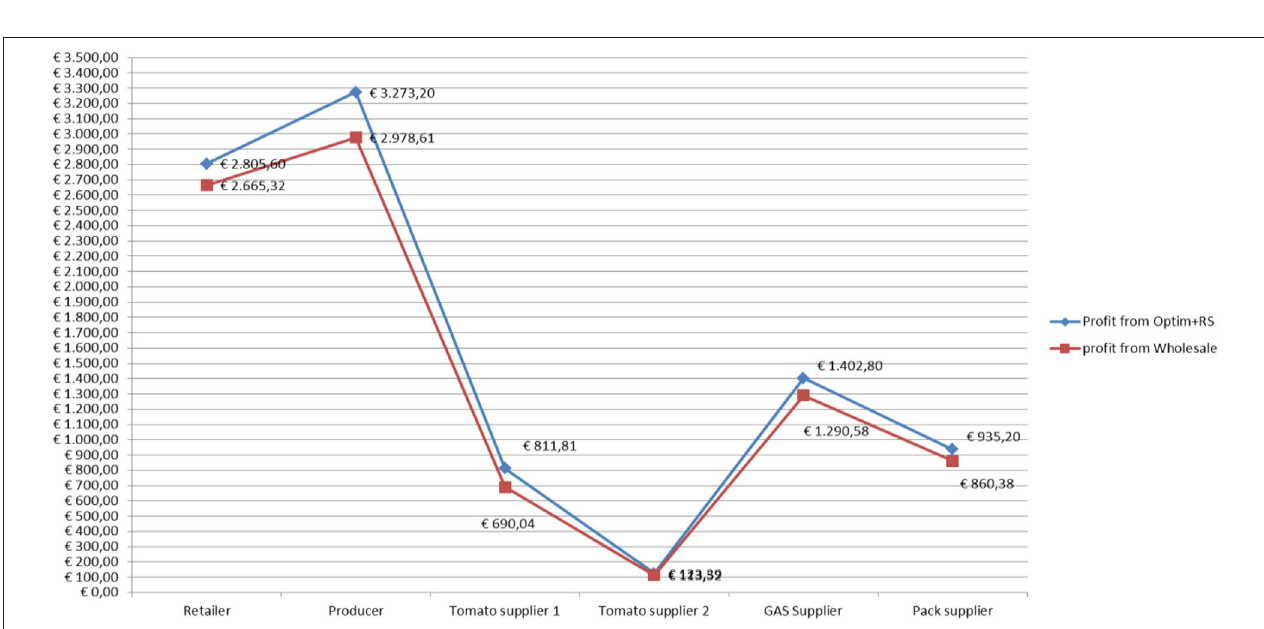
FIGURE 2 | Returns from vertical integration with a Revenue Sharing component in LEMURE.